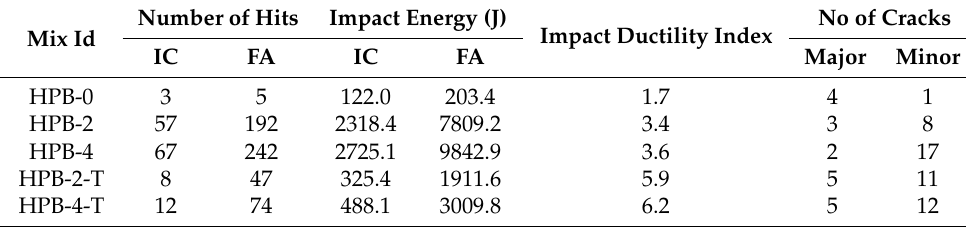
Table 4. Impact test results.